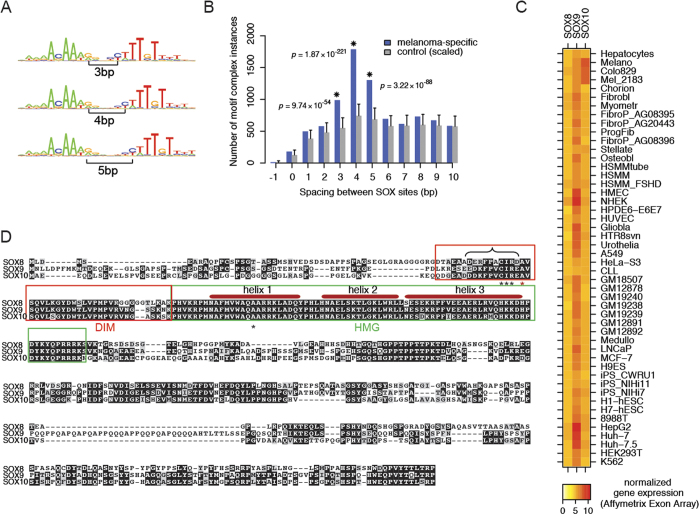
Melanoma cell enhancers are enriched for certain palindromic SOX motifs, suggesting SOXE dimerization. (A) Palindromic composite SOX motifs, consisting of juxtaposed TRANSFAC motifs, found overrepresented in melanoma-specific DNase I hypersensitive sites (DHS). Spacer size is indicated. (B) Numbers of instances of palindromic SOX complexes within melanoma-specific DHS (blue bars) for various spacings between SOX motifs. Grey bars indicate the expectation based on the control set, along with significance threshold for p < 0.05 after Bonferroni correction. Asterisks indicate strongly overrepresented SOX dimers; their Bonferroni-corrected p-values calculated by TACO31 are shown. (C) ENCODE/Duke Affymetrix Exon Array expression levels for human SOXE genes in 48 of the 59 cell lines used for dimer motif detection. For the remaining 11 cell lines such expression data were not available. SOX10 shows an expression peak in melanoma cell lines (Colo829, Mel_2183 and Melano). (D) Alignment of mouse SOXE proteins. Black asterisk indicate amino acids shown to be critical for SOXE dimerization45. The red asterisk mark the A76E missense mutation and the curly bracket the 66–75 aa deletion mutant detected in campomelic dysplasia patients reported to abrogate cooperative dimer formation29. DIM and HMG domains are marked with red or green boxes.